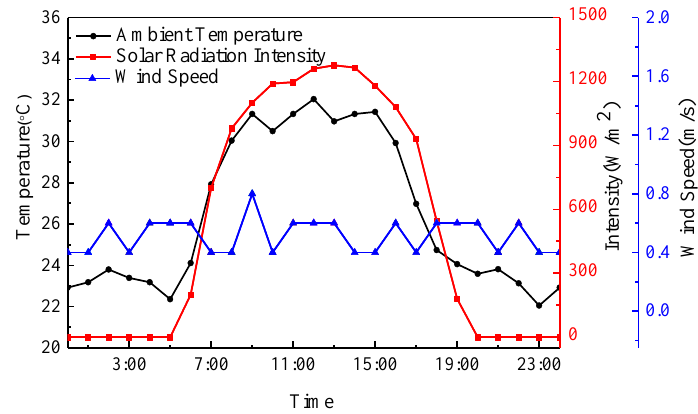
Figure 4. The variation curves of thermal boundary parameters